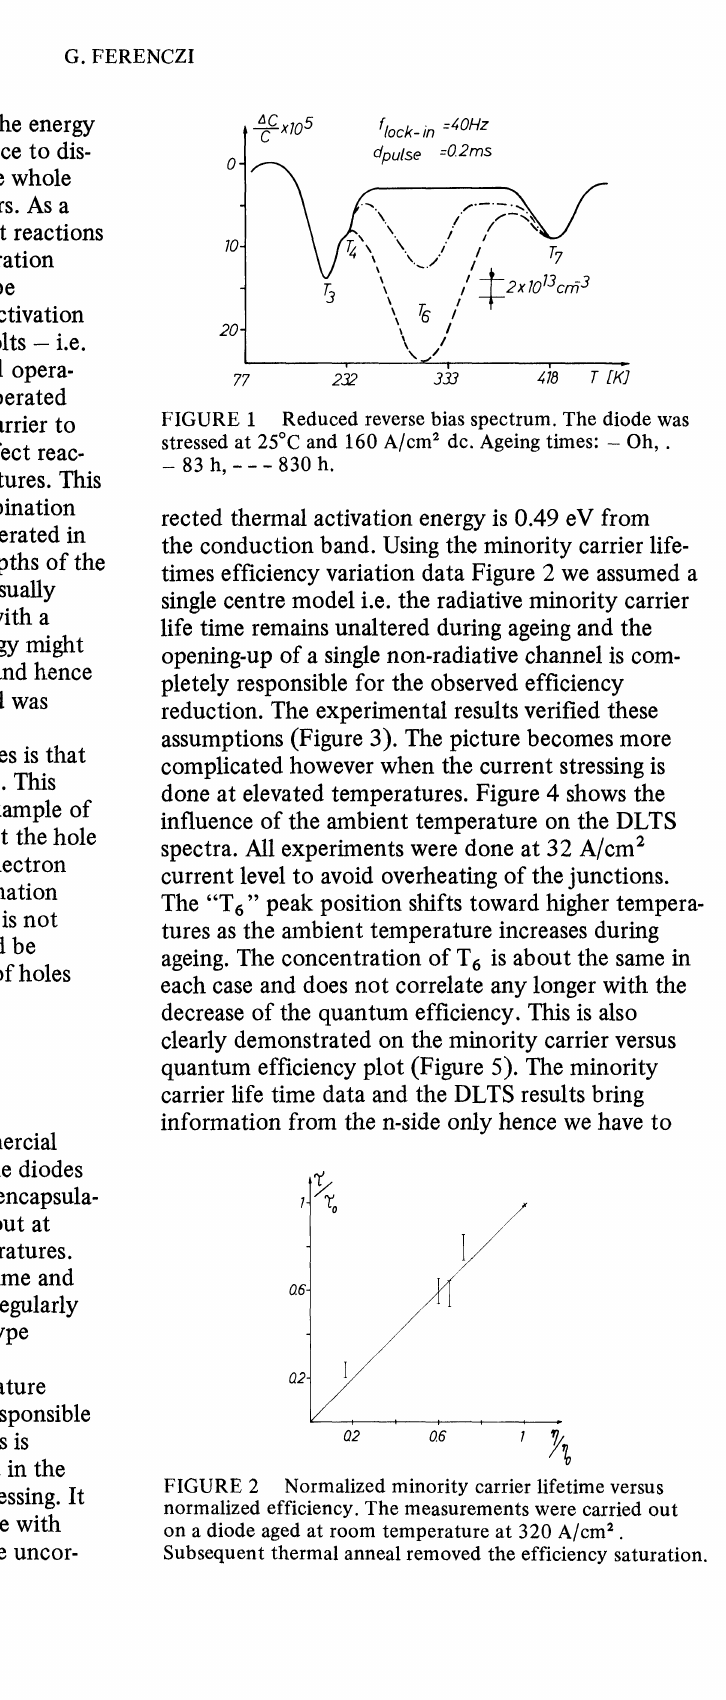
Normalized minority carrier lifetime versus normalized efficiency. The measurements were carried out on a diode aged at room temperature at 320 A/cm Subsequent thermal anneal removed the efficiency